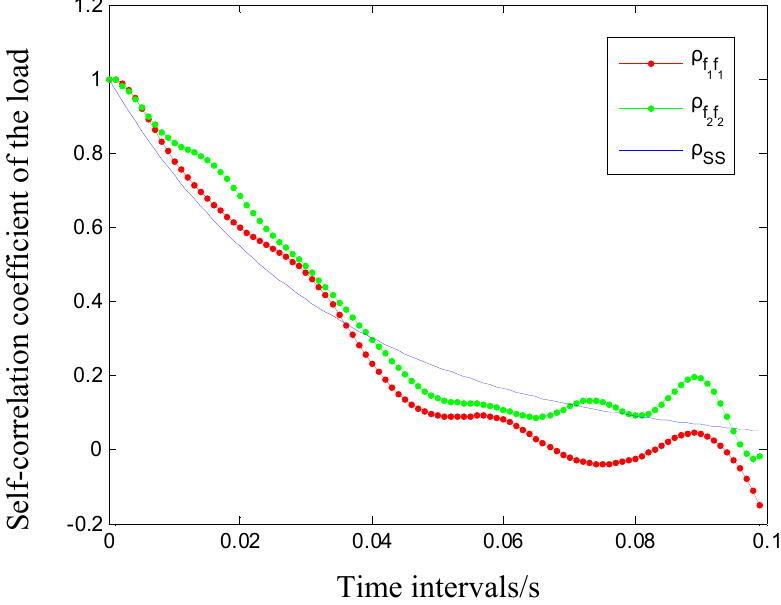
Figure 13. The self-correlation coefficient functions of the loads.